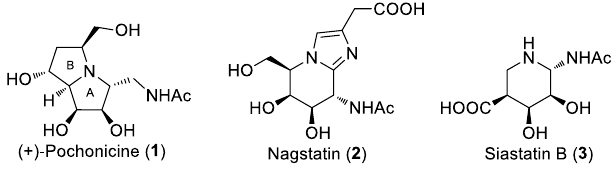
Figure 1. Naturally occurring potent N -acetylhexosaminidases (HexNAcase) inhibitors.